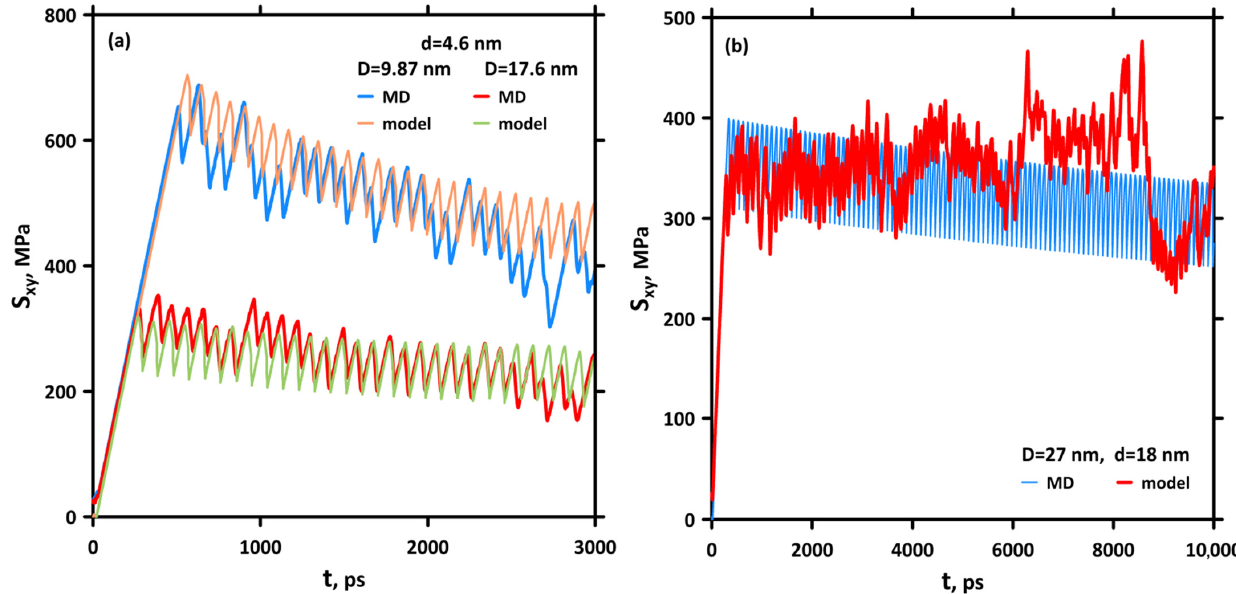
Figure 10. Time dependences of shear stresses averaged over system for precipitates with diameters d of 4.6 nm ( a ) and 18 nm ( b ) and different distances D between inclusions: 9.87 and 17.6 nm ( a ) and 27 nm ( b ). Comparison of results for multiple dislocation–precipitate interactions obtained by the model and the MD.